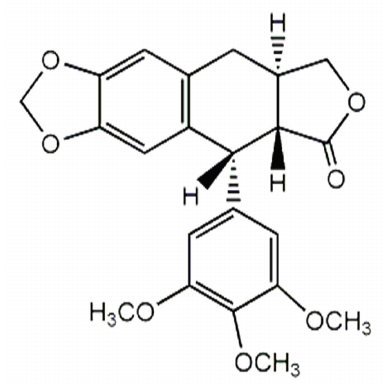
Figure 9. The chemical structure of anthricin